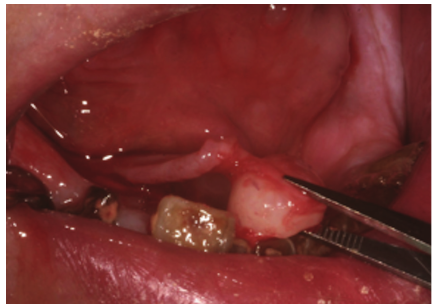
Figure 3: TM. Er:YAG laser